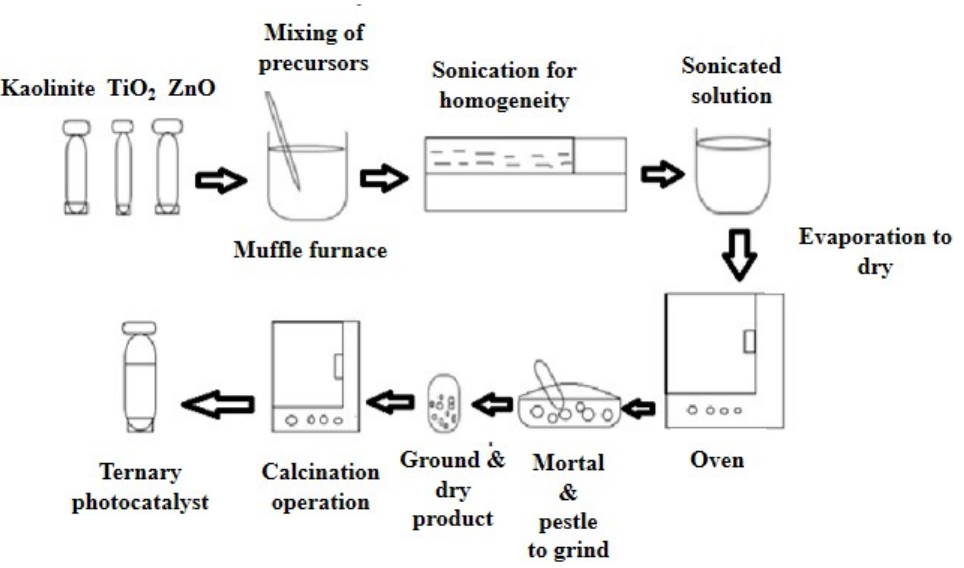
Figure 2. Scheme of ternary photocatalyst preparation.